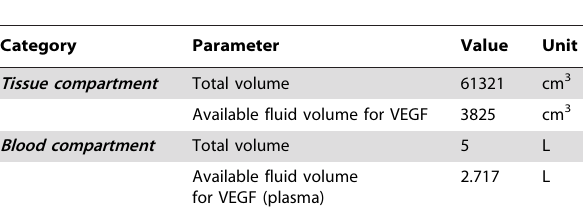
Table 4. Geometric parameters of the compartments [9].